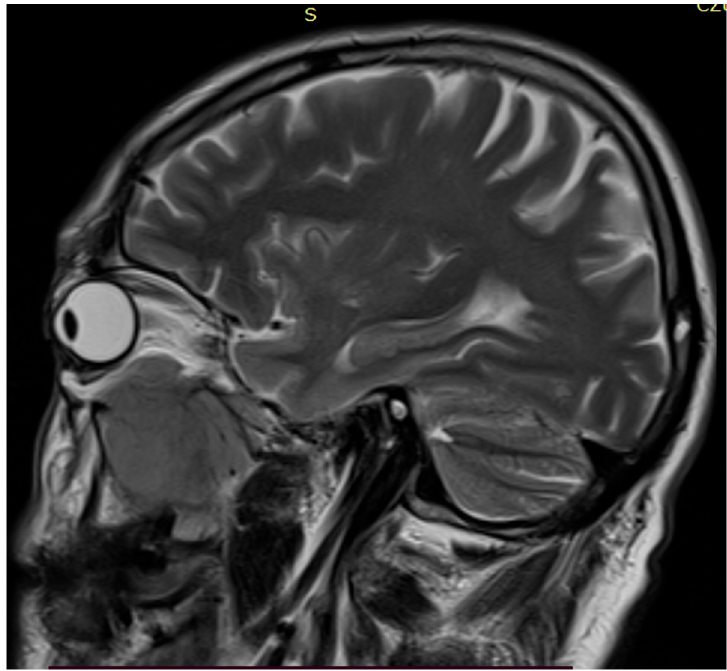
Figure 2. Head MR scan: large tumor evolving from maxillary sinus.